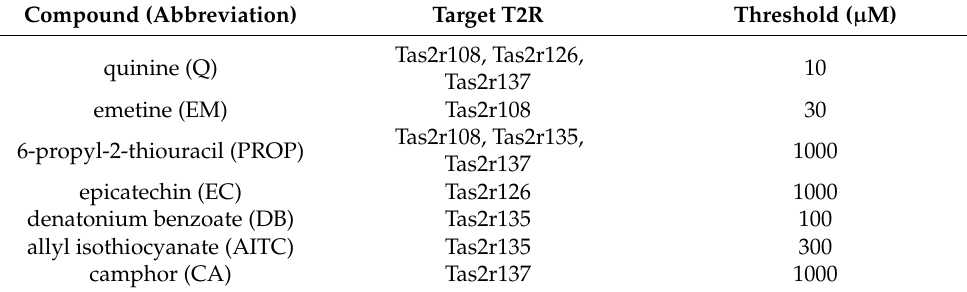
Figure 1. Induction of differentiation increased the expression of Tas2r genes in 3T3-L1 adipocytes. Total RNA was extracted from 3T3-L1 preadipocytes (undifferentiated) or mature adipocytes (dif- ferentiated). Tas2r expression was determined by real-time quantitative PCR (RT-qPCR) analysis. The actin beta gene ( Actb ) was used as the reference gene. N = 6, * p < 0.05, ** p < 0.01, *** p < 0.001 (differentiated vs. undifferentiated, Sidak test). Table 1. Bitter compounds and threshold concentrations for activation of mouse taste 2 receptors (T2Rs)